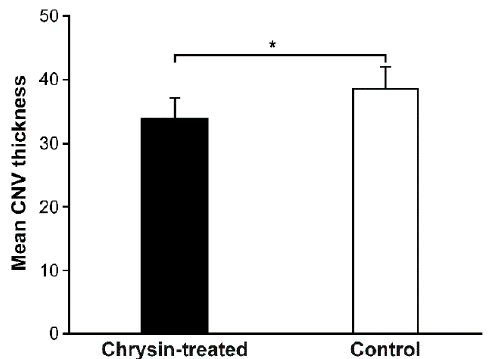
Figure 2. The thickness of experimental CNV lesions in chrysin-treated and control groups. Nine days after intravitreal chrysin treatment, the mean CNV thickness was compared between the chrysin-treated and control groups. CNV lesions in the chrysin-treated group were significantly thinner than those in the control group ( n = 30 CNV lesions from 5 eyes / group; * p < 0.01, unpaired Student’s t -test). CNV, choroidal neovascularization.